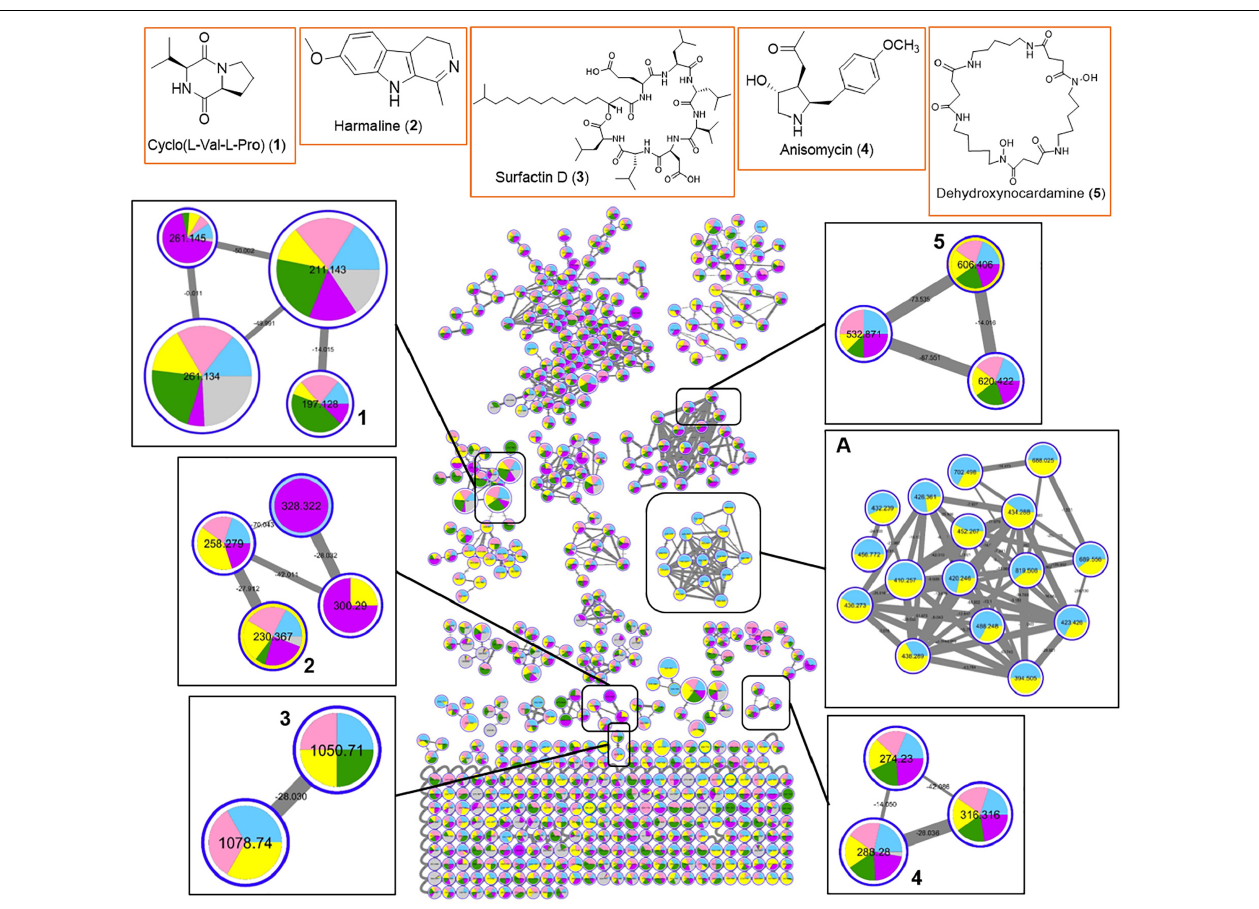
FIGURE 5 | Molecular network of 591 parent ions detected in extracts of five QSI active marine bacterial strains. Blue: strain #53; Pink: strain #91; Yellow: strain #48; Green: strain #93; Purple: strain #41; Gray: MeOH blank. Within each box, the nodes represent the number of ions detected in the bacterial extracts while the node size represents the relative abundance of the different parent ions. Within each node, the relative abundance of a particular ion detected in the different bacterial strains is depicted by the sizes of the colored wedge. The edge thickness reflects the similarity between each parent ions with thicker edge showing higher similarity. Nodes with associated numbers 1 to 5 correspond to the detected compounds and their chemical structures are shown in the top row of boxes.